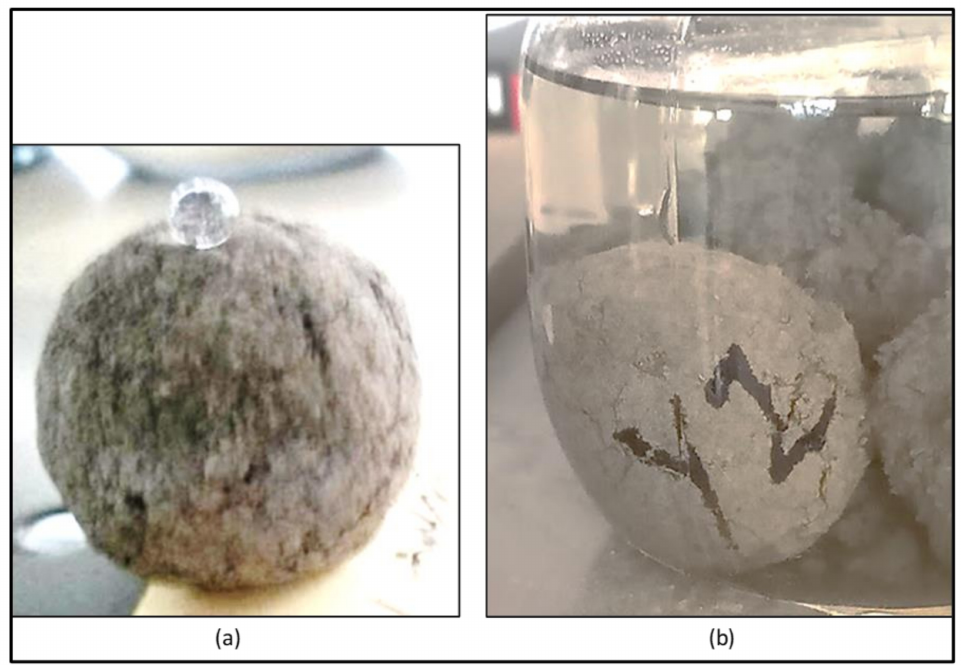
Figure 15. Black-cotton soil treated with a sub-nano-size silane and stabilised with a nano-silane- modified nano-polymer in an emulsion form (NME) compacted by hand with a water drop showing the perfect hydrophobicity achieved ( a ) and after 7 days submerged in water ( b ) (Testing performed